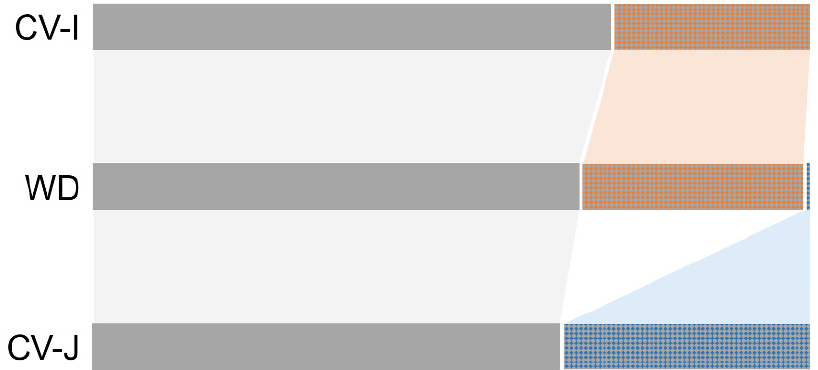
Figure 4. The proportion of different haplotypes of the qsh1 gene shared by the examined weedy rice (WD) and cultivated rice (CV). The gray bars represent the haplotypes shared by the indica cultivated (CV-I), weedy (WD), and japonica cultivated (CV-J) rice samples. The light-brown and light-blue bars indicate the proportion of specific haplotypes shared by indica cultivated and weedy or by japonica cultivated and weedy rice samples, respectively.